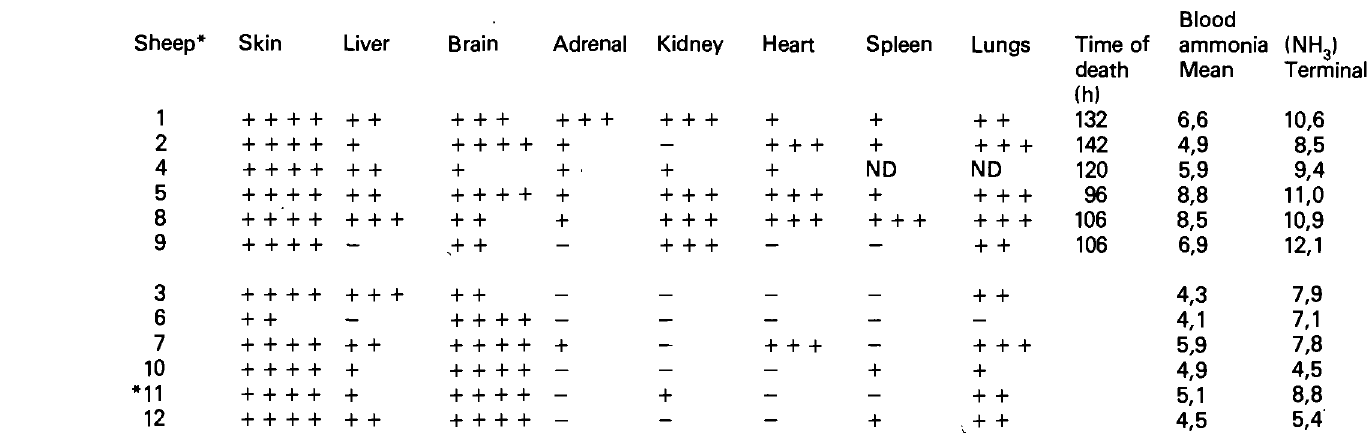
Table 1: Pathological change in tissues, time of death (hours) and mean and terminal jugular lipid soluble ammonia concentration